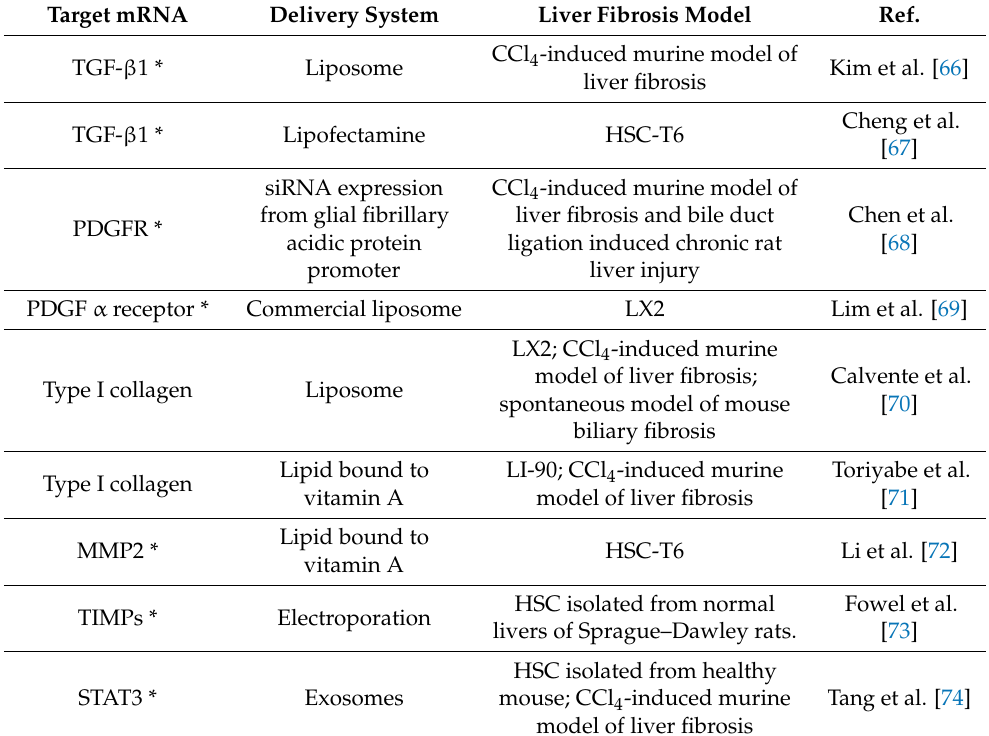
Table 4. siRNA employment in liver